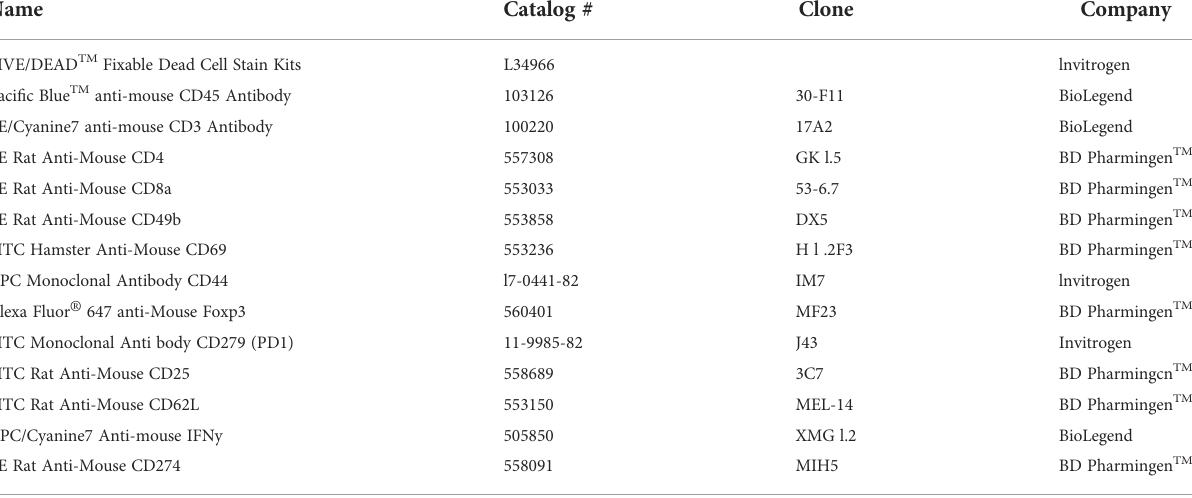
TABLE 1 List of antibodies used in fl ow